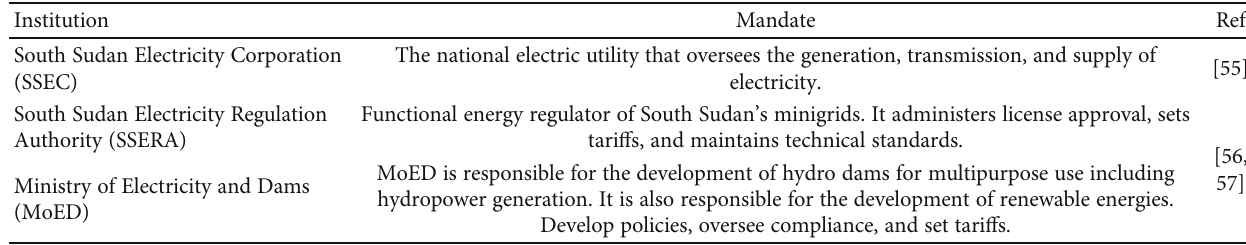
Table 18: Descriptions of institutions involved in the energy sector in South